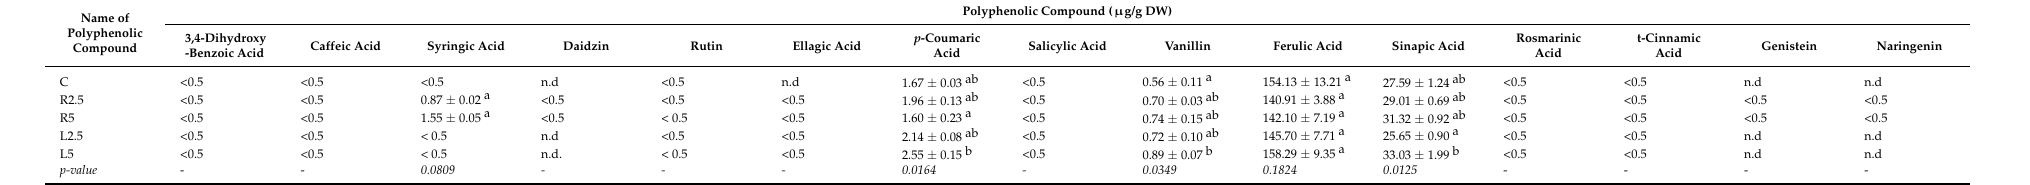
Table 2. Qualitative–quantitative analysis of phenolic compounds using the LC-MS/MS